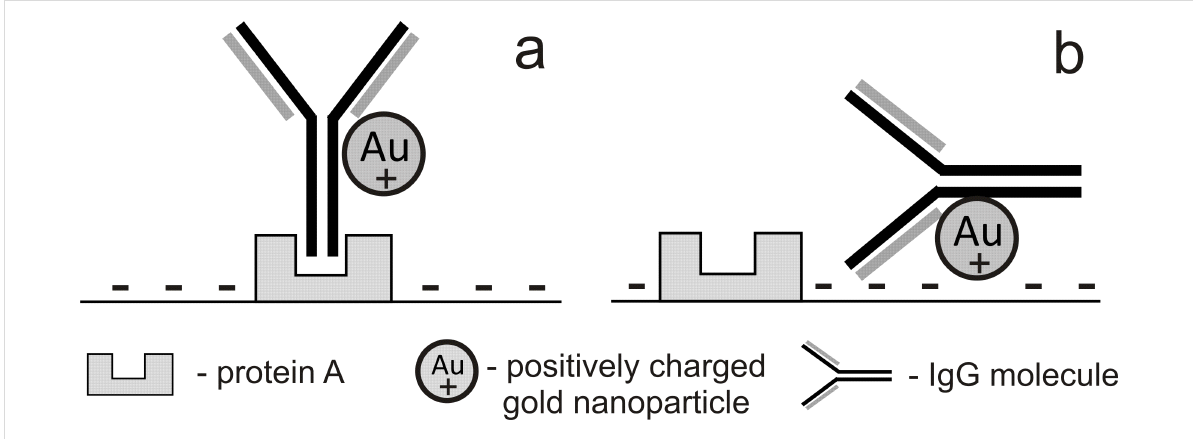
Figure 4: Two types of conjugate interactions with bacterial cell surfaces: selective binding of the Fc region of IgG in a non-antigenic way to protein A (a); non-selective electrostatic binding of colloidal gold to membrane (b).